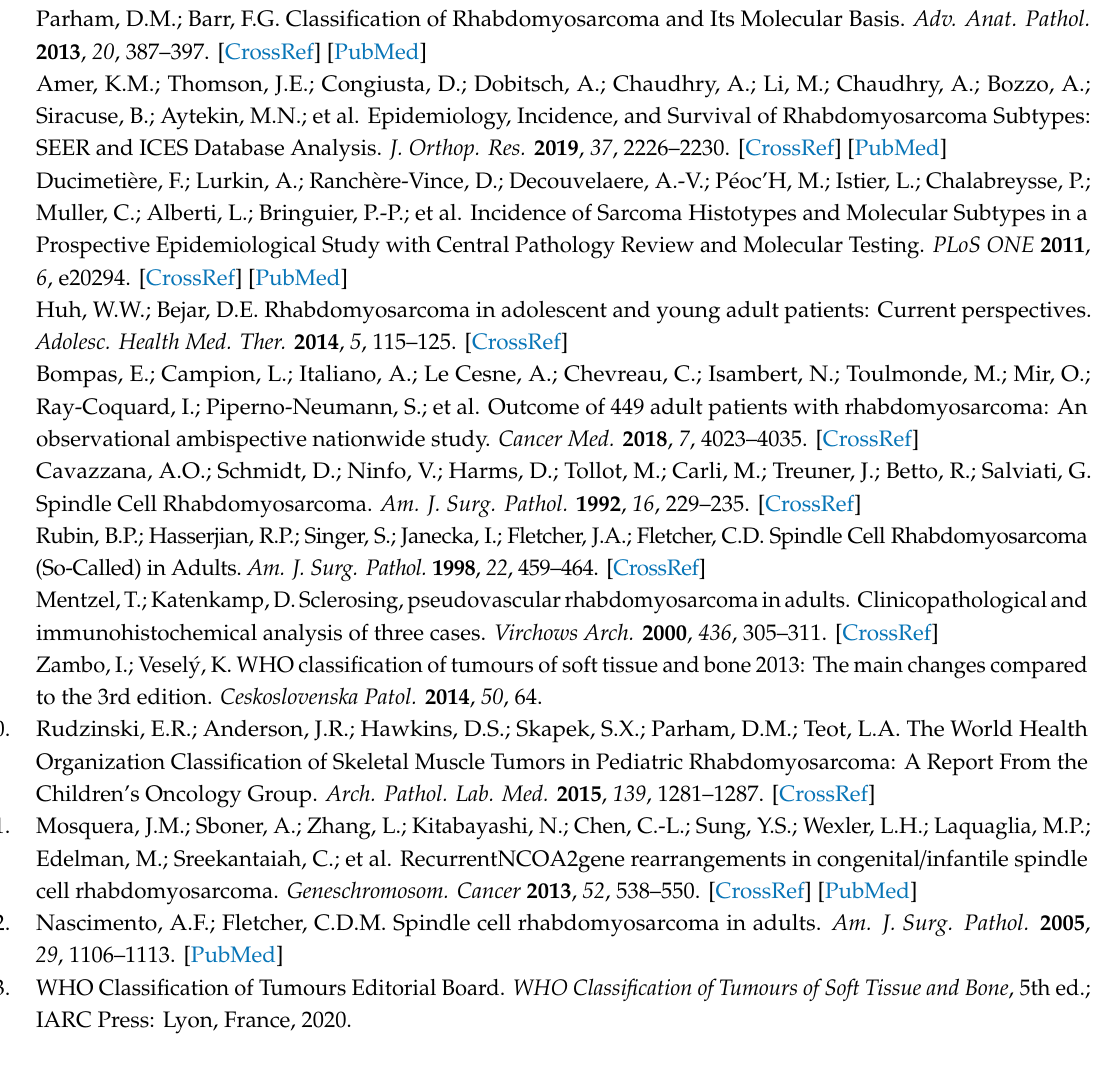
Figure S1: Array-CGH results; Figure S2: Hh signaling pathway; Figure S3: NOTCH signaling pathway, Table S1: Array-CGH tabular results by probe